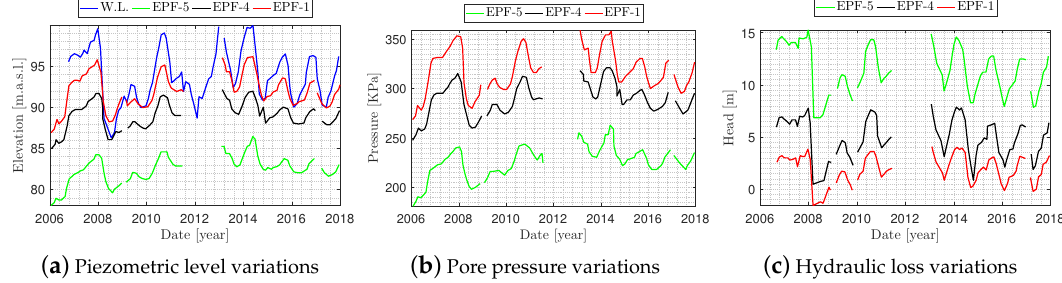
Figure 6. Recorded data by vibration wire piezometers at section